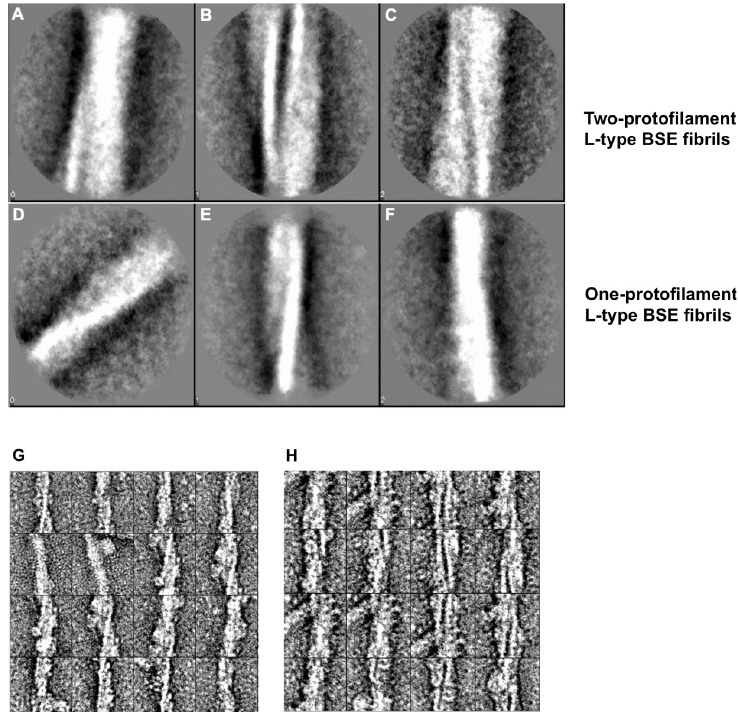
Fig 6. Alignment, classification, and averaging of L-type BSE fibrils. ( A-C ) Reference-free alignment and classification of particles of two-protofilament L-type BSE fibrils. Class averages of 297 segmented particles exhibiting different regions of the fibrils, including the crossover region ( A ), showing two intertwined protofilaments with an apparent, stain-filled gap between them. ( D-F ) Class averages from the reference-free alignment of 532 particles of one-protofilament L-type BSE prion fibrils. All three class averages show a single helical filament only. Representative images of aligned fibril segments of one- ( G ) and ( H ) two-protofilament fibrils before classification.